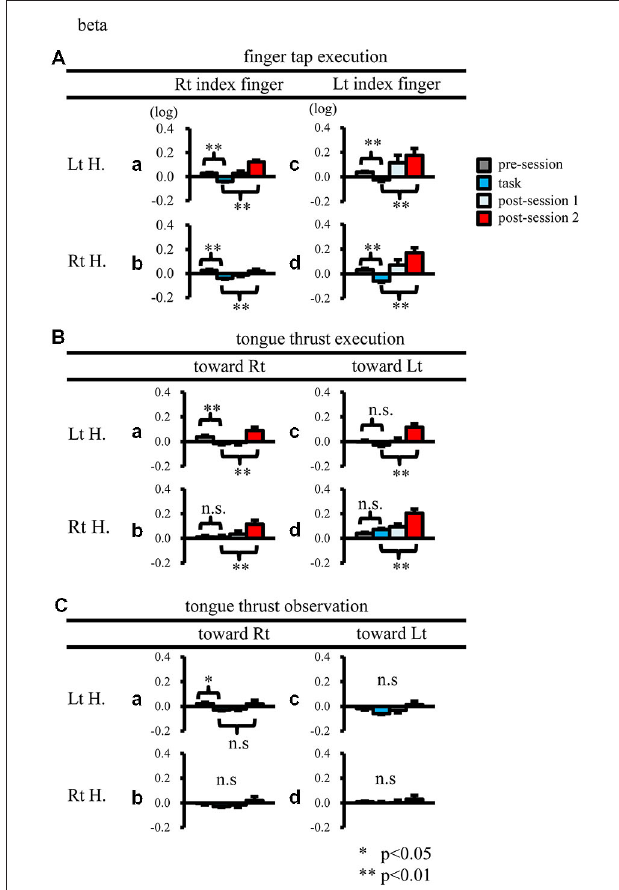
FIGURE 4 | Logarithmic electroencephalogram (EEG) power ratios (ERD, negative; ERS, positive) for the beta band . Upper columns are log (ratios) for finger tap execution (A) , middle for tongue thrust execution (B) , and bottom for tongue thrust observation (C) . Each plot (a–d) represents the log (ratio) during each epoch (pre-session, task, post-session 1, post-session 2) in the left hemisphere (Lt H., a and c ) and right hemisphere (Rt H., b and d ) evoked by right index finger tapping (A-a,b) , rightward tongue thrust execution (B-a,b) , rightward tongue thrust observation (C-a,b) , left index finger tapping (A-c,d) , leftward tongue thrust execution (B-c,d) , and leftward tongue thrust observation (C-c,d) . ∗ p < 0.05; ∗∗ p <